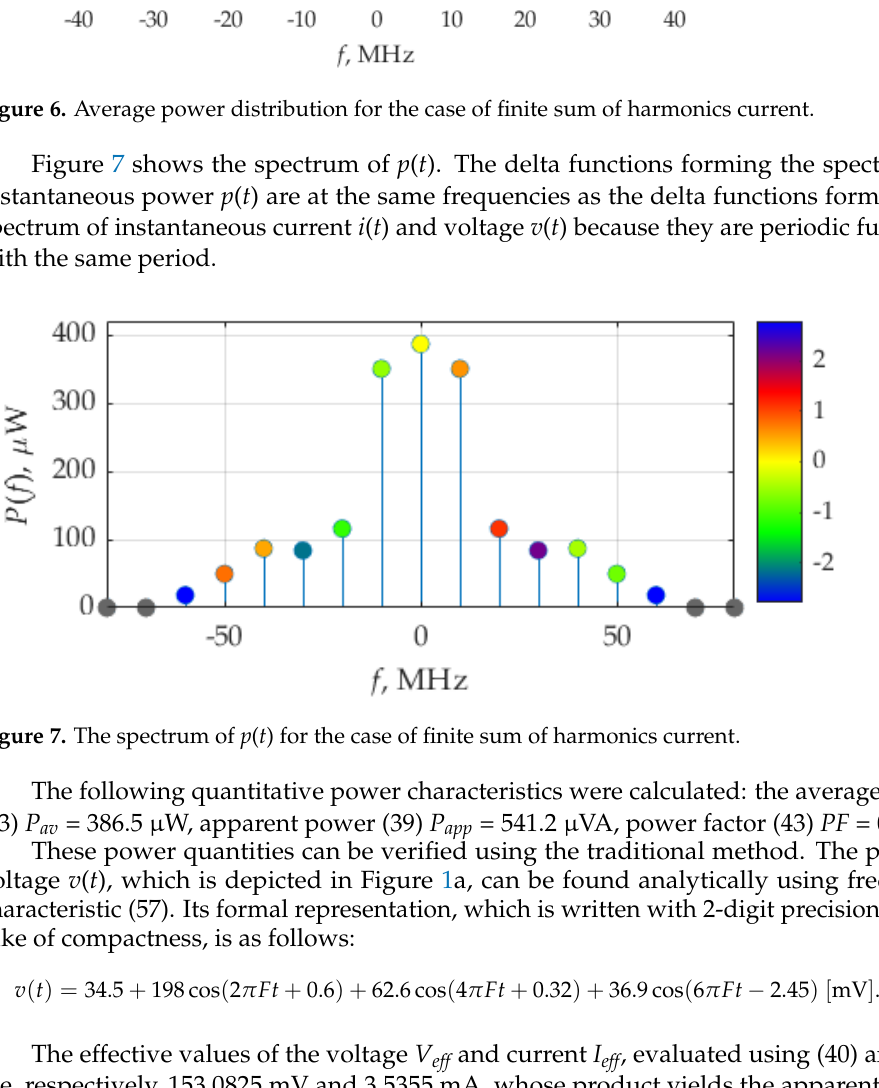
Figure 6. Average power distribution for the case of finite sum of harmonics current.